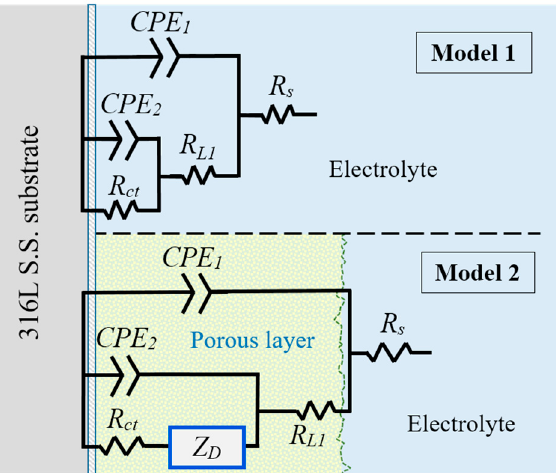
Figure 19. Equivalent circuit models of the corrosion mechanisms observed at the active interfaces: Model 1 for uncoated substrate, Model 2 for BG-PLA coatings.